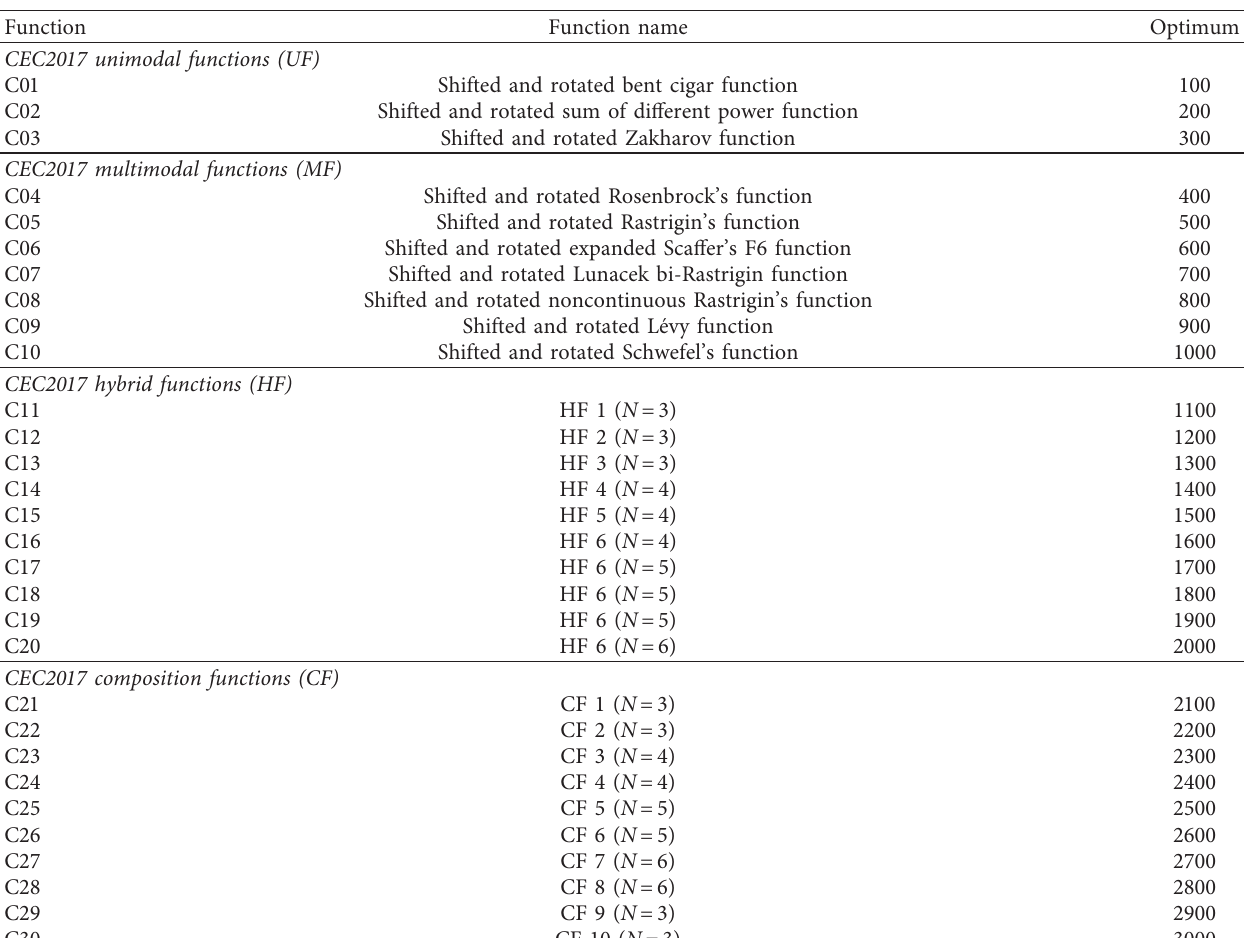
Table 1: CEC2017 test functions.